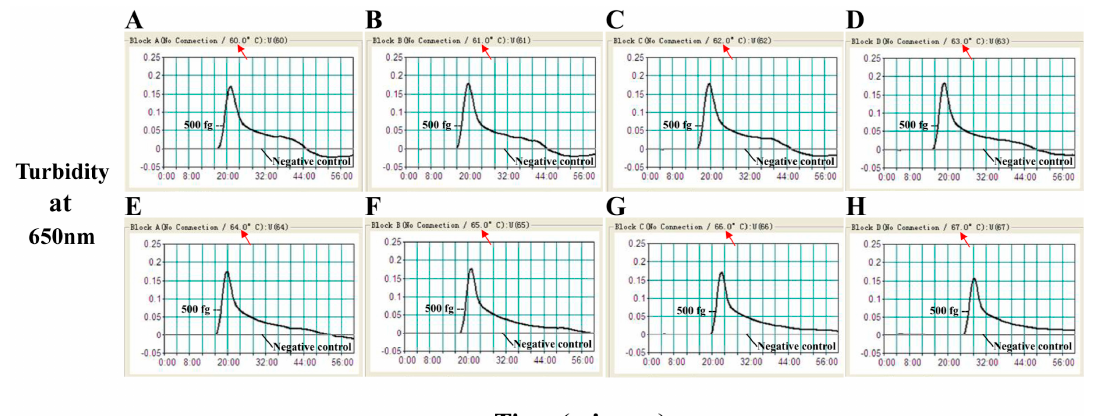
Figure 2. The optimal temperature for the LAMP assay. The LAMP amplifications reactions were analyzed by real-time measurement of turbidity and the corresponding curves of concentrations of DNA were marked in the Figure. The threshold value was 0.1 and the turbidity of >0.1 was considered to be positive. Eight kinetic graphs ( A – H ) were obtained at different temperature (60–67 ◦ C) with B. quintana DNA at the level of 500 fg per reaction.